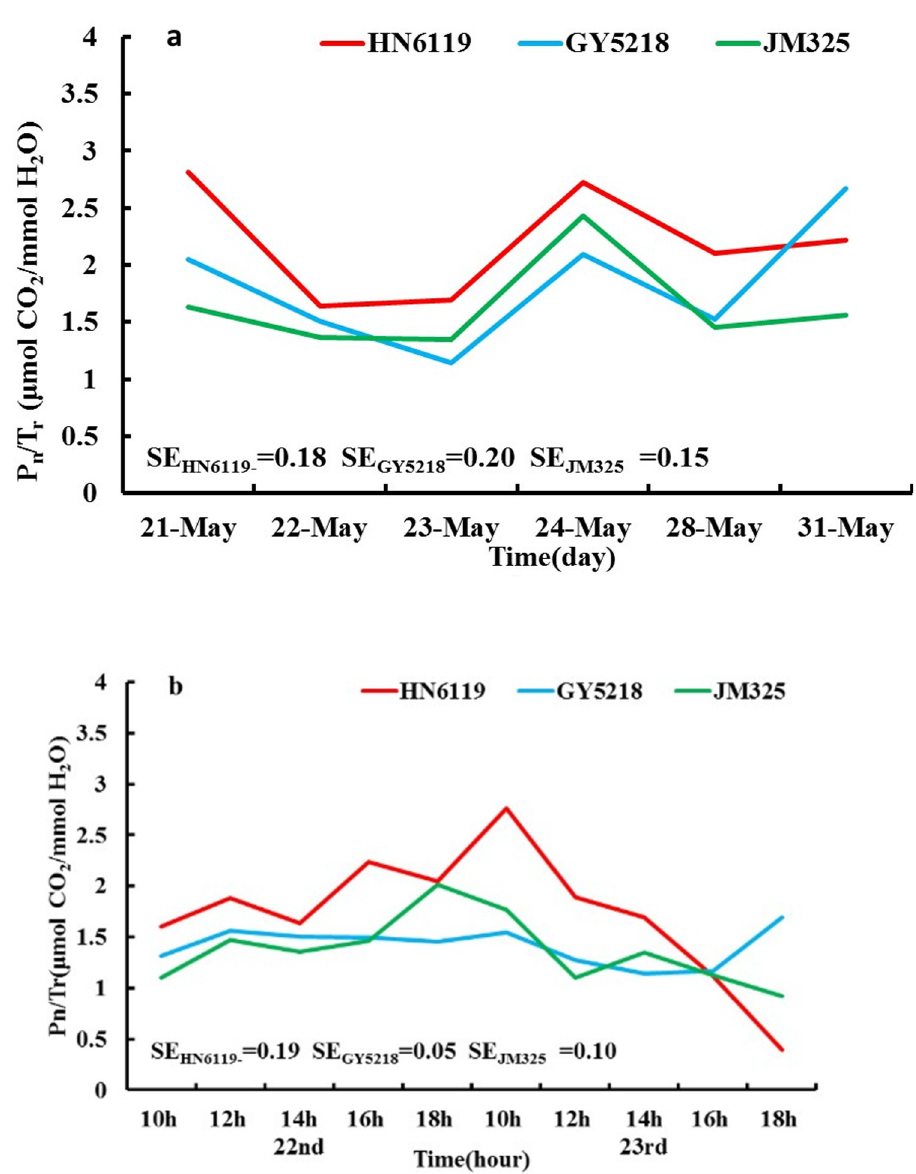
Fig 4. As in Fig 1, but for (a) leaf photosynthetic water use efficiency (WUE) (unit: μ mol CO 2 /mmol H 2 O) from May 21 st to 24 th and on May 28 th and May 31 st , 2019; (b) leaf photosynthetic WUE (unit: μ mol CO 2 /mmol H 2 O) from May 22 nd to 23 rd , 2019. (SE is the abbreviation of the standard error of P n /T r